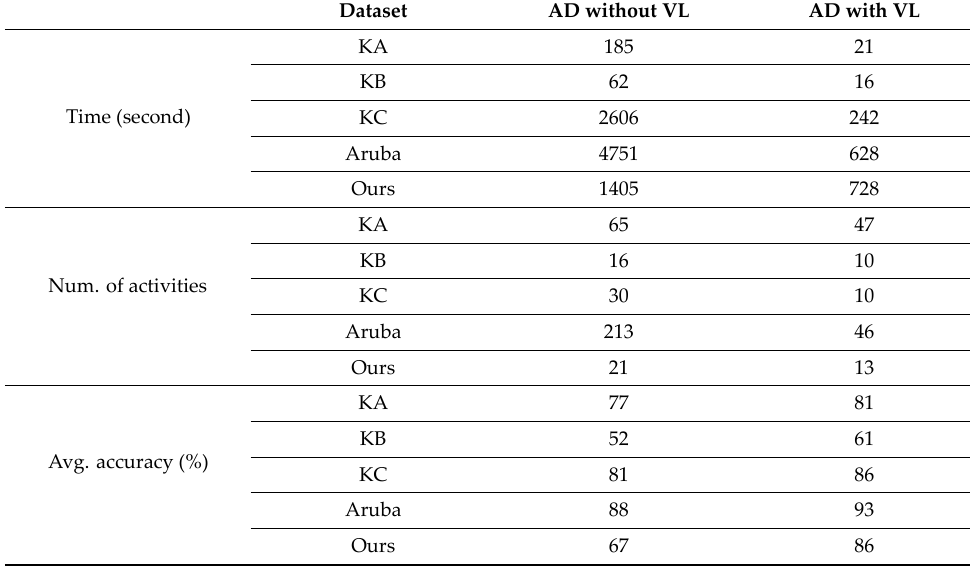
Table 7. Results of activity discovery in each